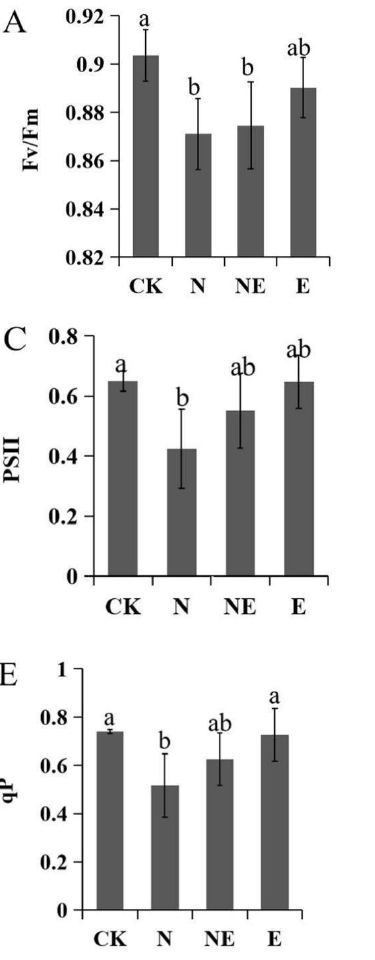
Figure 6. Effects of EBL treatments on chlorophyll fluorescence parameters of peanut seedling under salt stress. CK (normal conditions), N (treated with 150 mM NaCl), NE (treated with 150 mM NaCl and 0.1 µM EBL) and E (treated with 0.1 µM EBL). ( A ) Fv/Fm; ( B ) Fv’/Fm’; ( C ) PSII; ( D ) ETR; ( E ) qP; ( F ) NPQ. Different lowercase letters indicate significant differences between treatments ( p < 0.05).